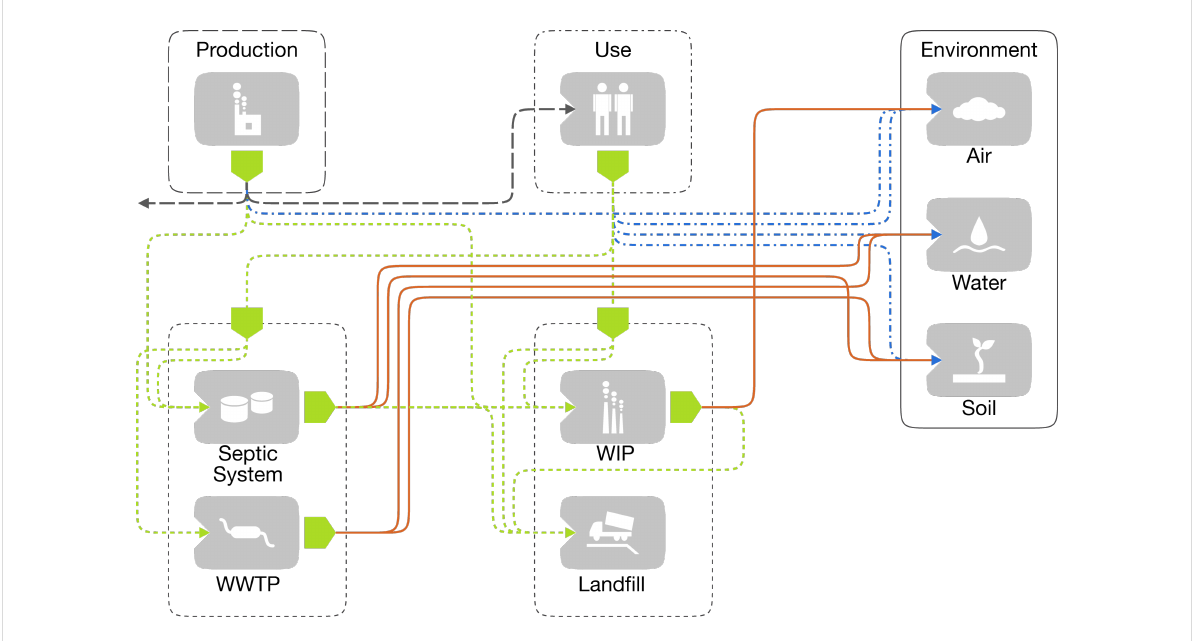
Figure 3: Lifecycle tracking of ENMs. The various lines represent the paths for which transfer coefficients quantify the portion of ENMs transferred from the source to the target compartments. Blue dash-dot lines represent direct release to environmental compartments from production and use, green dotted lines represent ENM transfer from production and use to waste processing facilities, orange solid lines represent indirect release to envi- ronmental compartments from waste processing facilities, and gray dashed lines represent import/export and ENM transfer from production to